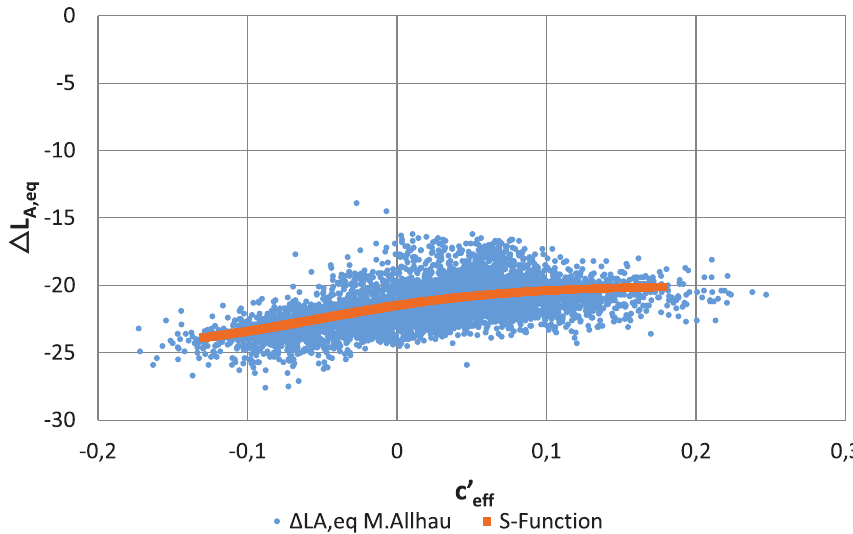
Figure 10. Markt Allhau: Sound level difference D L A ,eq versus effective sound speed gradient ( c 0 eff ) with S-shaped